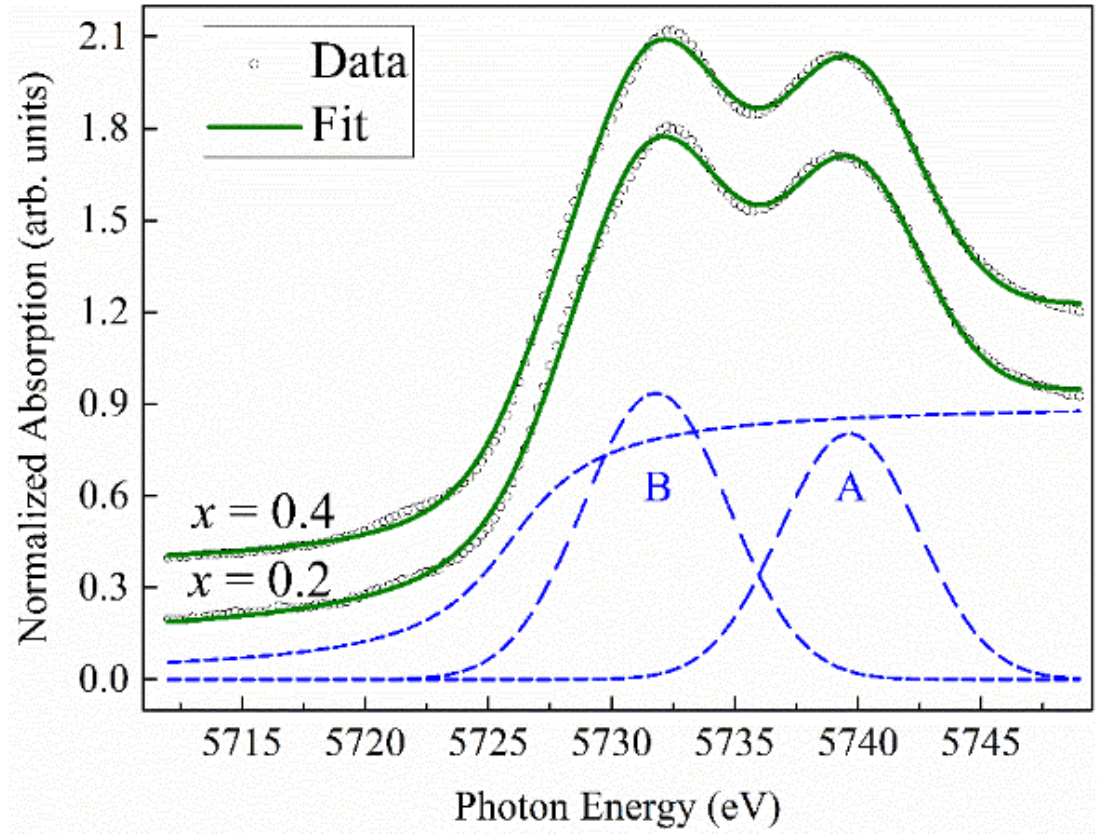
Figure 5. XANES spectra at the Ce L 3 edge of La 1 − x Ce x CoO 3 , with ( A ) x = 0.2 and ( B ) x = 0.4, and results of least-squares-fit analyses. The dashed lines indicate the fitting procedure. Table 6. Details of local coordination for La and Co of the main phase, as a result of the Rietveld refinement analysis. Numbers in parentheses are statistical errors of the last significant digit.